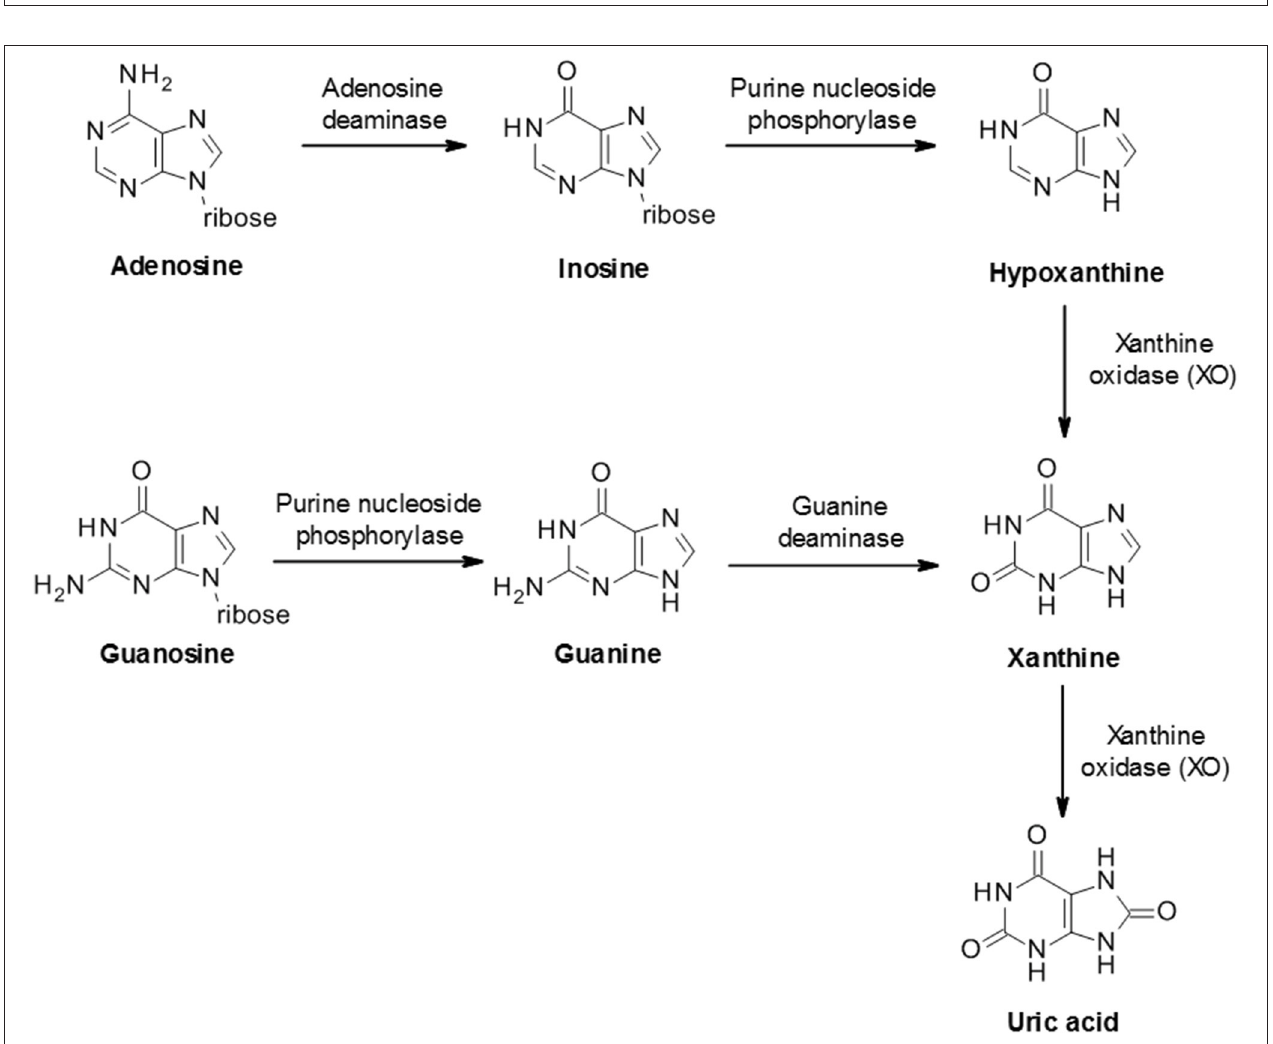
renal excretion or low FEUA represents a major contributor to hyperuricemia as opposed to increased generation of uric